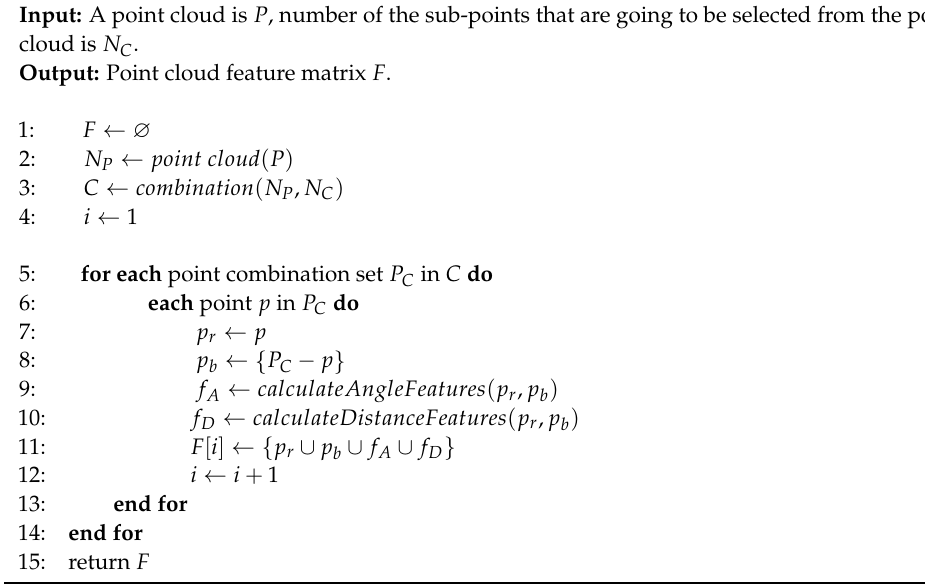
Algorithm 1. Generation of point cloud